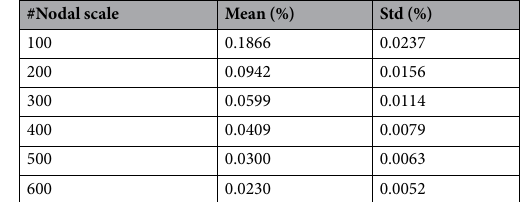
Table 1. The ratio of the number of short fibers and U-fibers to the maximum possible number of connections at each nodal scale. The number of short fibers and U-fibers were determined based on the edges not included in calculation of the network hubs. The ratio showed that the number of short fibers and U-fibers steadily decreased as the nodal scale